Question: In a single sentence, describe what this figure presents.
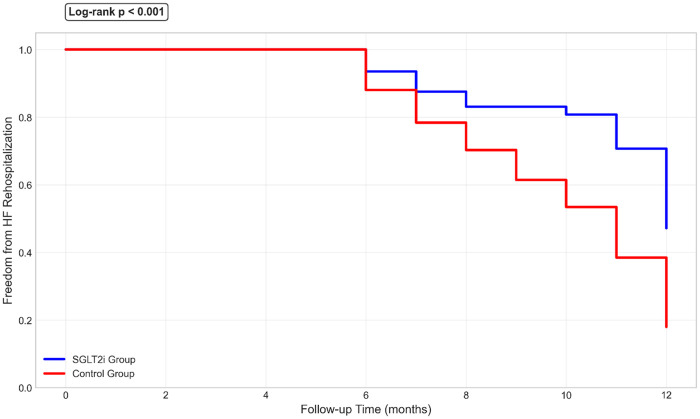
Answer: Kaplan–meier curve for freedom from heart failure rehospitalization.